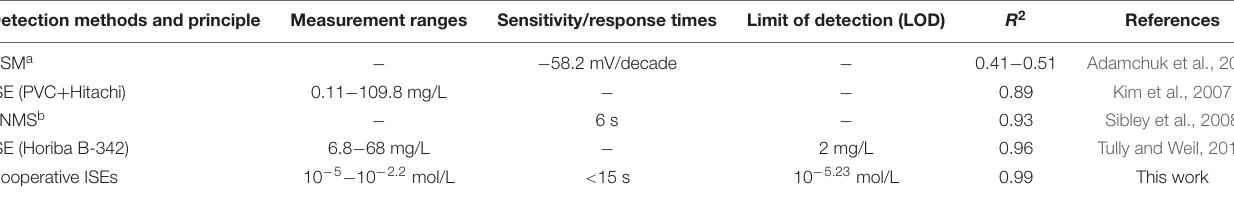
TABLE 5 | Performance comparison on NO − 3 -N measurement with different